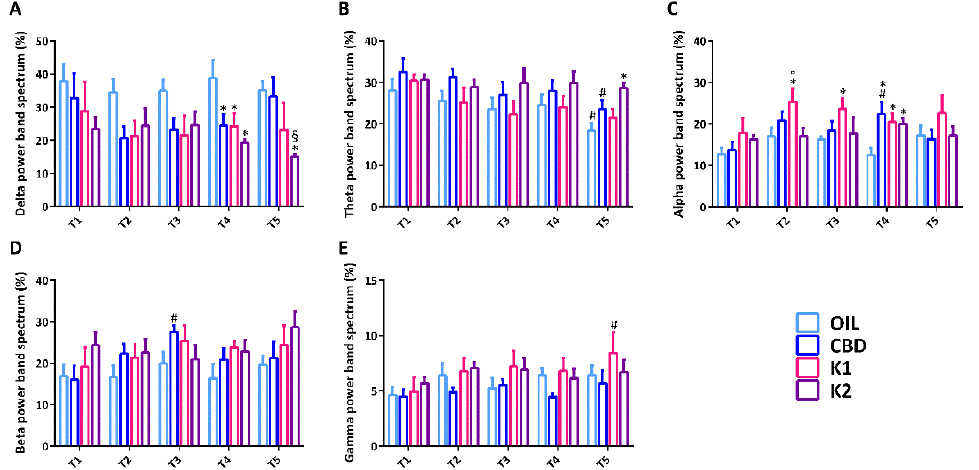
Figure 6. Power band spectrum analysis after each session of the 6-Hz test. All mice ( n = 32) were treated with CBD ( n = 8), K1 ( n = 8), K2 ( n = 8), or olive oil ( n = 8). A relative indication of distribution of power over the frequency, expressed in percentage, was determined in seizures induced by the 6-Hz corneal stimulation ( A – E ). * p < 0.050 vs. OIL; § p < 0.050 vs. CBD; ° p < 0.050 vs. K2; # p < 0.050